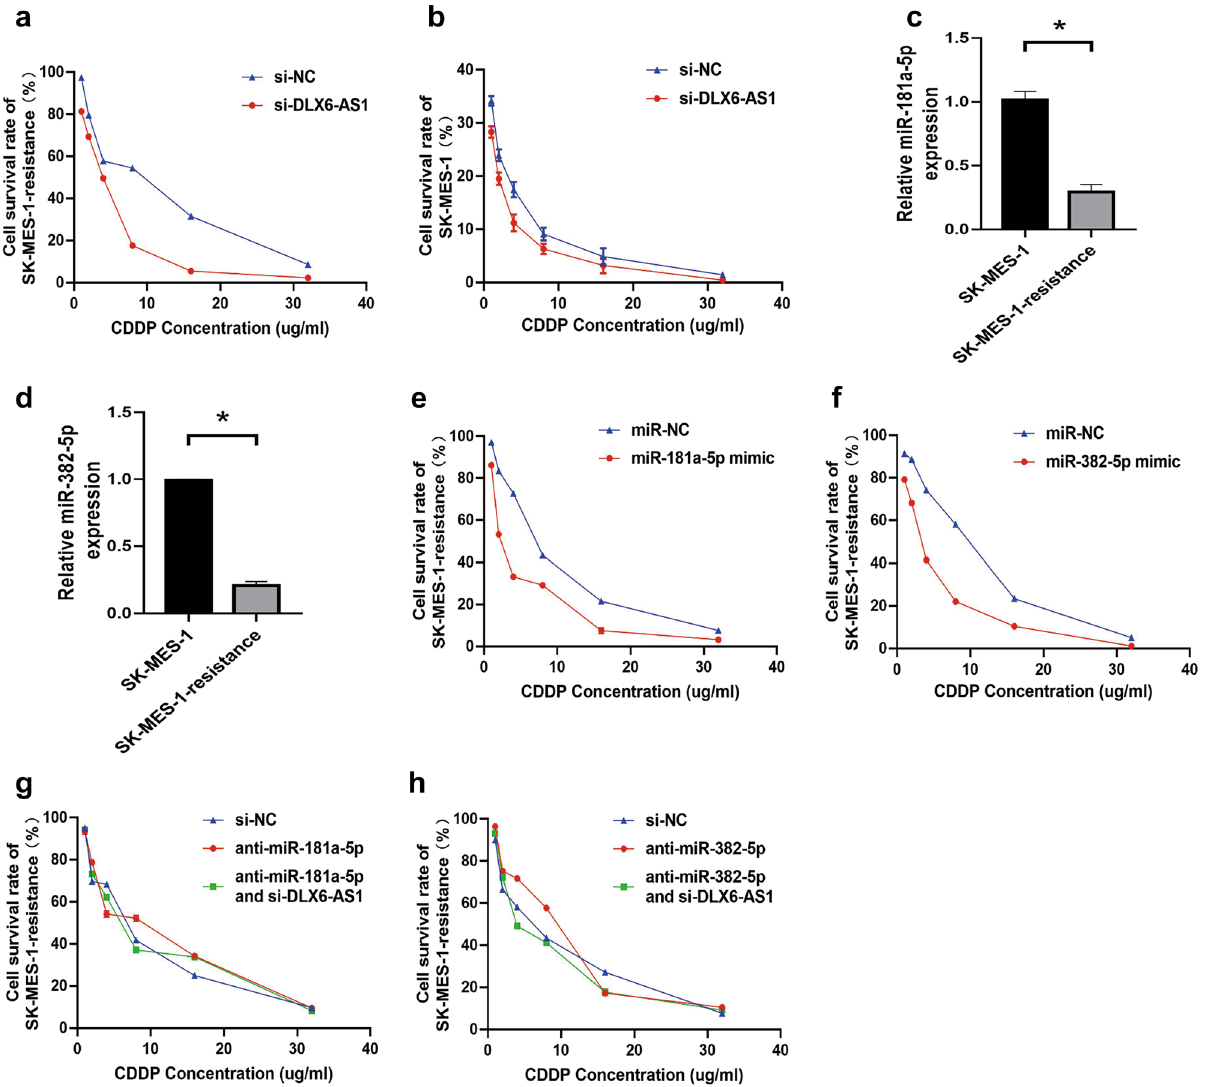
Figure 5. DLX6-AS1/miR-181a-5p/miR-382-5p regulation influenced the effect of secondary cisplatin resistance in LUSC cells. ( a ) CCK-8 assay for the IC50 of SK-MES-1-resistance cells transfected with si-DLX6-AS1 or si-NC and treated with CDDP. ( b ) CCK-8 assay for the IC50 of SK-MES-1 cells transfected with si-DLX6-AS1 or si-NC and treated with CDDP. ( c,d ) qRT-PCR analysis for the relative expression of miR- 181a-5p ( c ) or miR-382-5p ( d ) in SK-MES-1 or SK-MES-1-resistance cell lines. ( e,f ) CCK-8 assay for the IC50 of SK-MES-1-resistance cells transfected with miR-181a-5p mimic ( e ), miR-382-5p mimic ( f ) or their respective miR-NC and treated with CDDP. ( g ) CCK-8 assay for the IC50 of SK-MES-1-resistance cells transfected with anti-miR-181a-5p or si-DLX6-AS1 and treated with CDDP. ( h ) CCK-8 assay for the IC50 of SK-MES-1- resistance cells transfected with anti-miR-382-5p or si-DLX6-AS1 and treated with CDDP. * P <